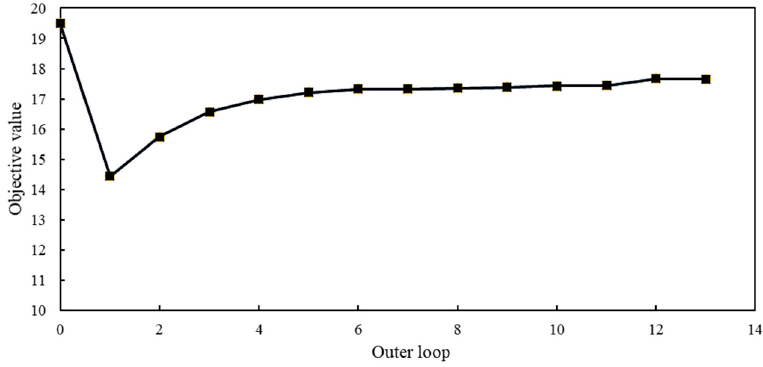
Figure 5. Iterative curve of ATC cycle with MIGA.